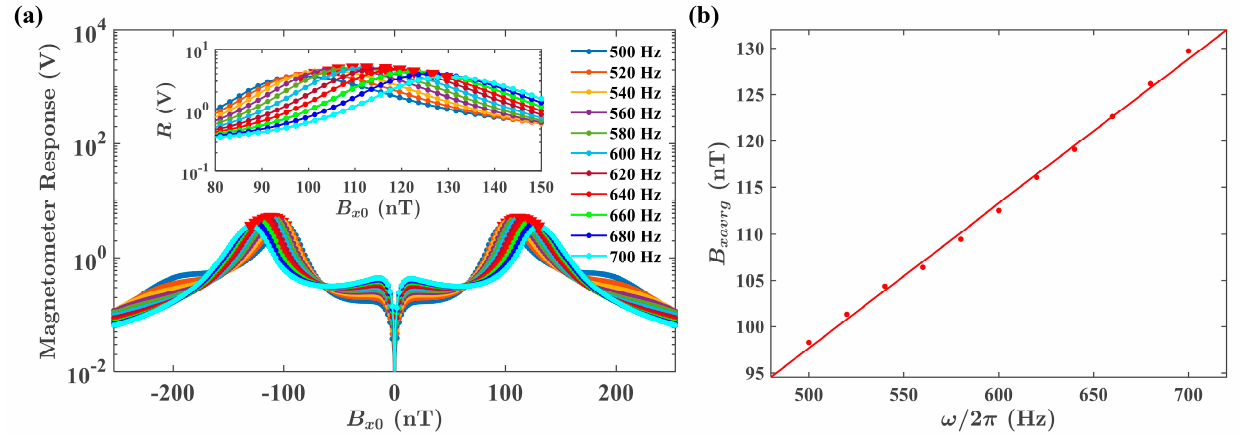
Figure 3. ( a ) Magnetometer responses when sweeping the magnetic field offset B x 0 under different modulated magnetic field frequencies ranging from 500 Hz to 700 Hz. Each peak of R at the first- order resonance is marked with a red inverted triangle and recorded. ( b ) Each first-order resonance point B xavrg (red solid circle) with different modulated magnetic frequencies ω /2 π . The fit value is presented as a red solid line.